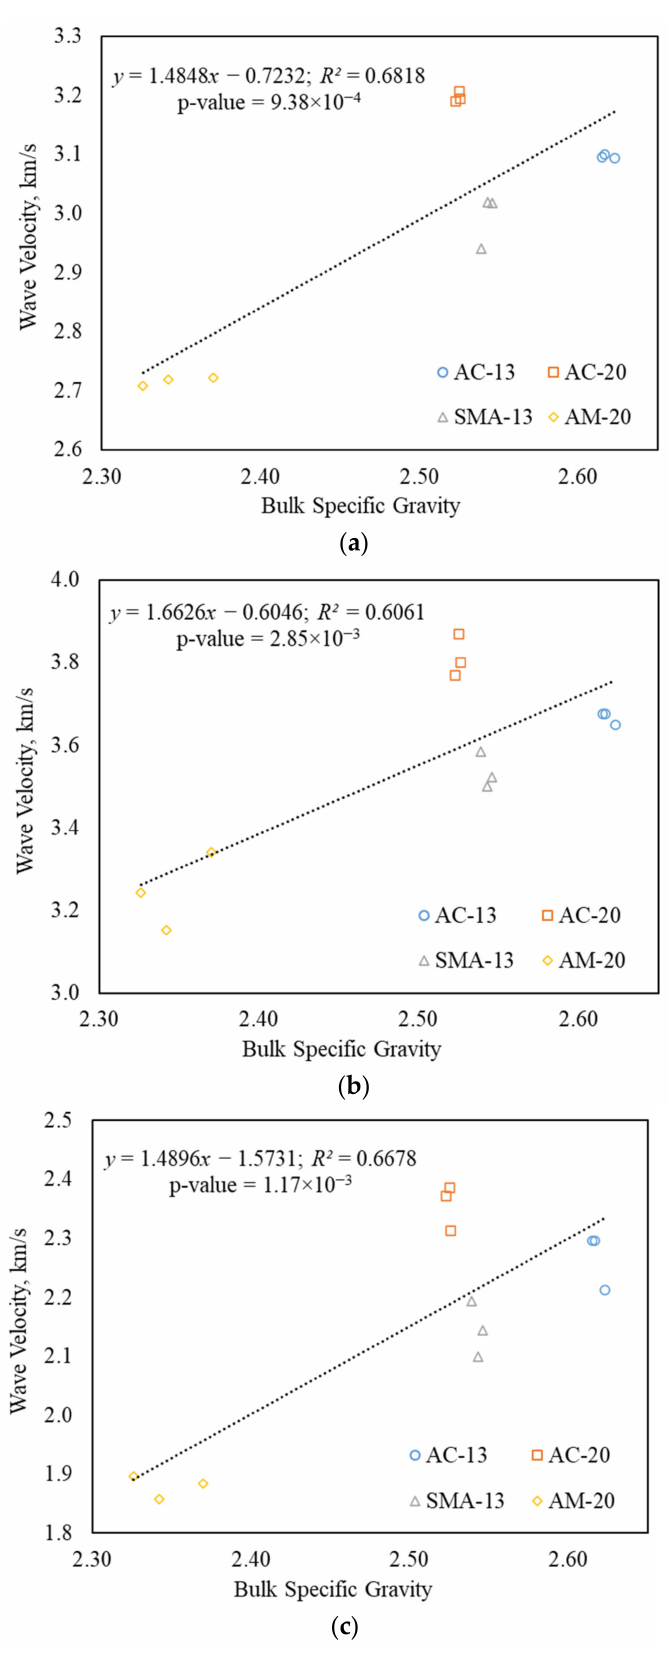
Figure 5. Wave velocity vs. bulk specific gravity: ( a ) ultrasonic wave test; ( b ) P-wave test. ( c ) S-wave